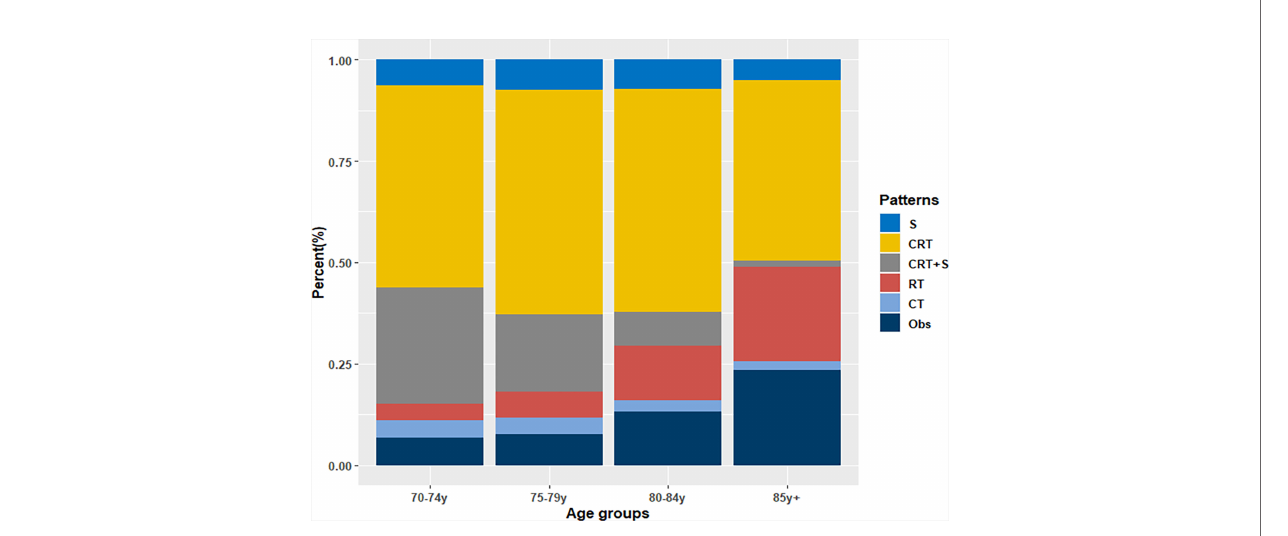
FIGURE 2 | Treatment patterns of elderly patients with EC by age group.